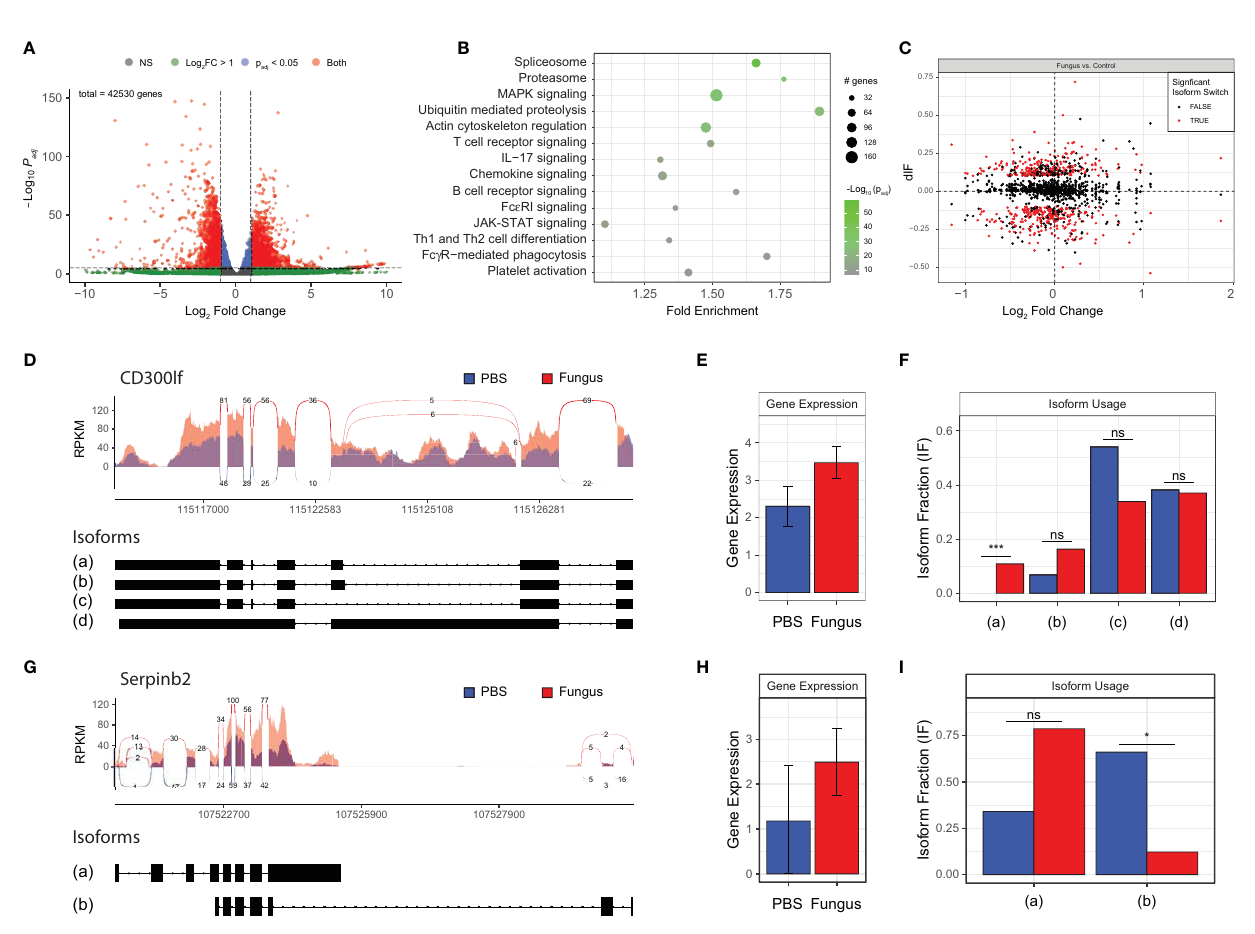
FIGURE 3 | Fungal-mediated enrichment of in fl ammatory pathways of differentially expressed genes (DEGs) reveals variable gene isoform usage. Mice were i.n. challenged with A. niger (AN) or PBS as in Figure 1A , total RNA was isolated from sinus, and RNA-seq analysis was performed. (A) Volcano plot of DEGs in fungal challenged mouse sinus tissue vs. vehicle in which gene expression is depicted as fold change versus adjusted p -value (log10). (B) KEGG enrichment of signi fi cant pathways, with color indicating statistical signi fi cance and circle size indicating the number of genes. (C) Isoform switch analysis of fold change in sequenced gene isoforms for fungal challenged mice vs. naïve controls (dIF), with signi fi cantly switched isoforms shown in red. CD300lf (D – F) and Serpinb2 (G – I) sashimi plots of read coverage with isoform exon maps (D, G) , total gene expression (E, H) , and isoform usage (F, I) . p adj < 0.05 and q < 0.05; n = 3 by Student ’ s t -test. * p < 0.05; *** p < 0.001; ns, not signi fi